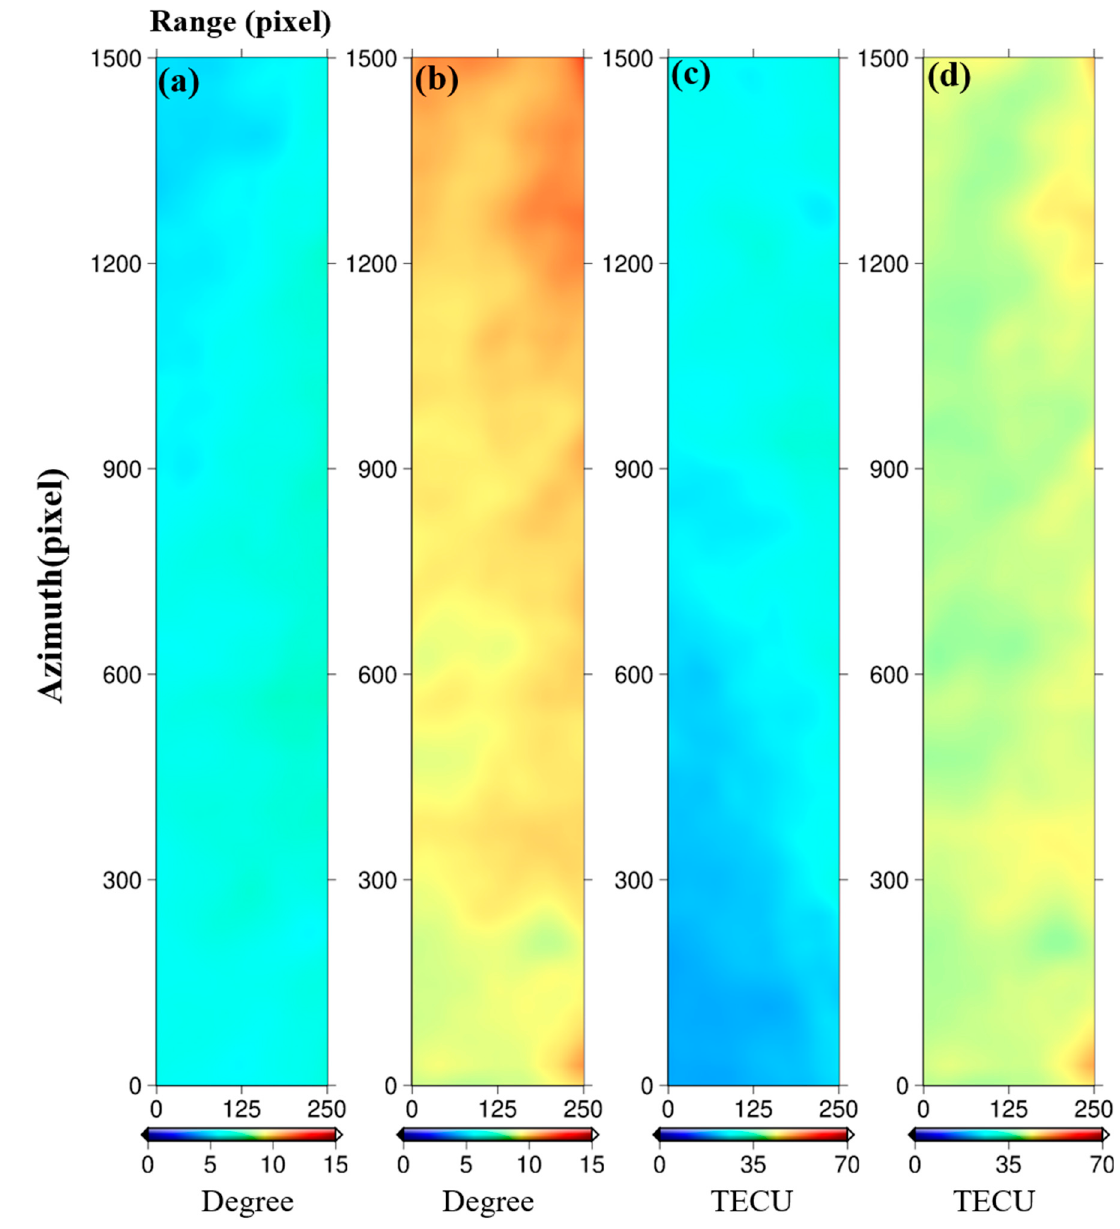
Figure 10. FR angles and VTEC maps. ( a , b ) FR angles on 26 March 2010 and 29 March 2011, respectively; ( c , d ) VTEC maps on 26 March 2010 and 29 March 2011, respectively.